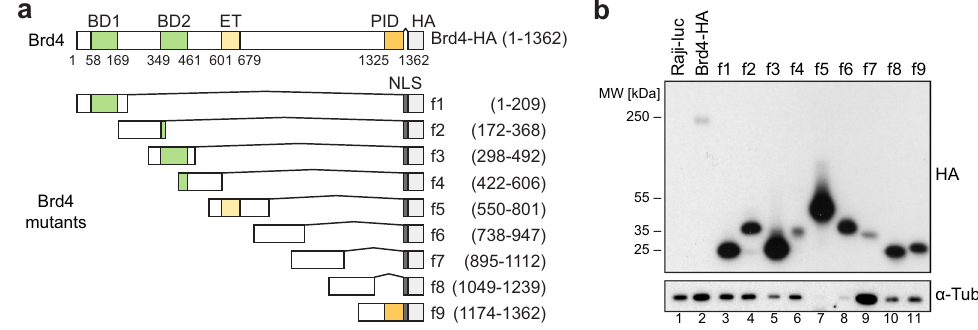
Figure 1. Expression system for Brd4 mutants. ( a ) Schematic structure of recombinant full-length human Brd4 protein (Brd4-HA) and Brd4 fragments f1–f9. BD1/2 = bromodomain 1/2, ET = extra-terminal domain, PID = P-TEFb-interacting domain, HA = hemagglutinin tag, NLS = nuclear localization signal. ( b ) Expression levels of HA-tagged Brd4 mutants, assessed via western analysis of the HA tag. α -Tubulin served as loading control. Samples were diluted with loading buffer prior to loading to visualize all signals on a single membrane (dilution ratios: lanes 2 and 9, 1:1; lanes 1, 3, 4, 6, 10 and 11, 1:10; lanes 5, 7 and 8, 1:20). Raji-luc cells expressed an non-tagged luciferase and served as negative